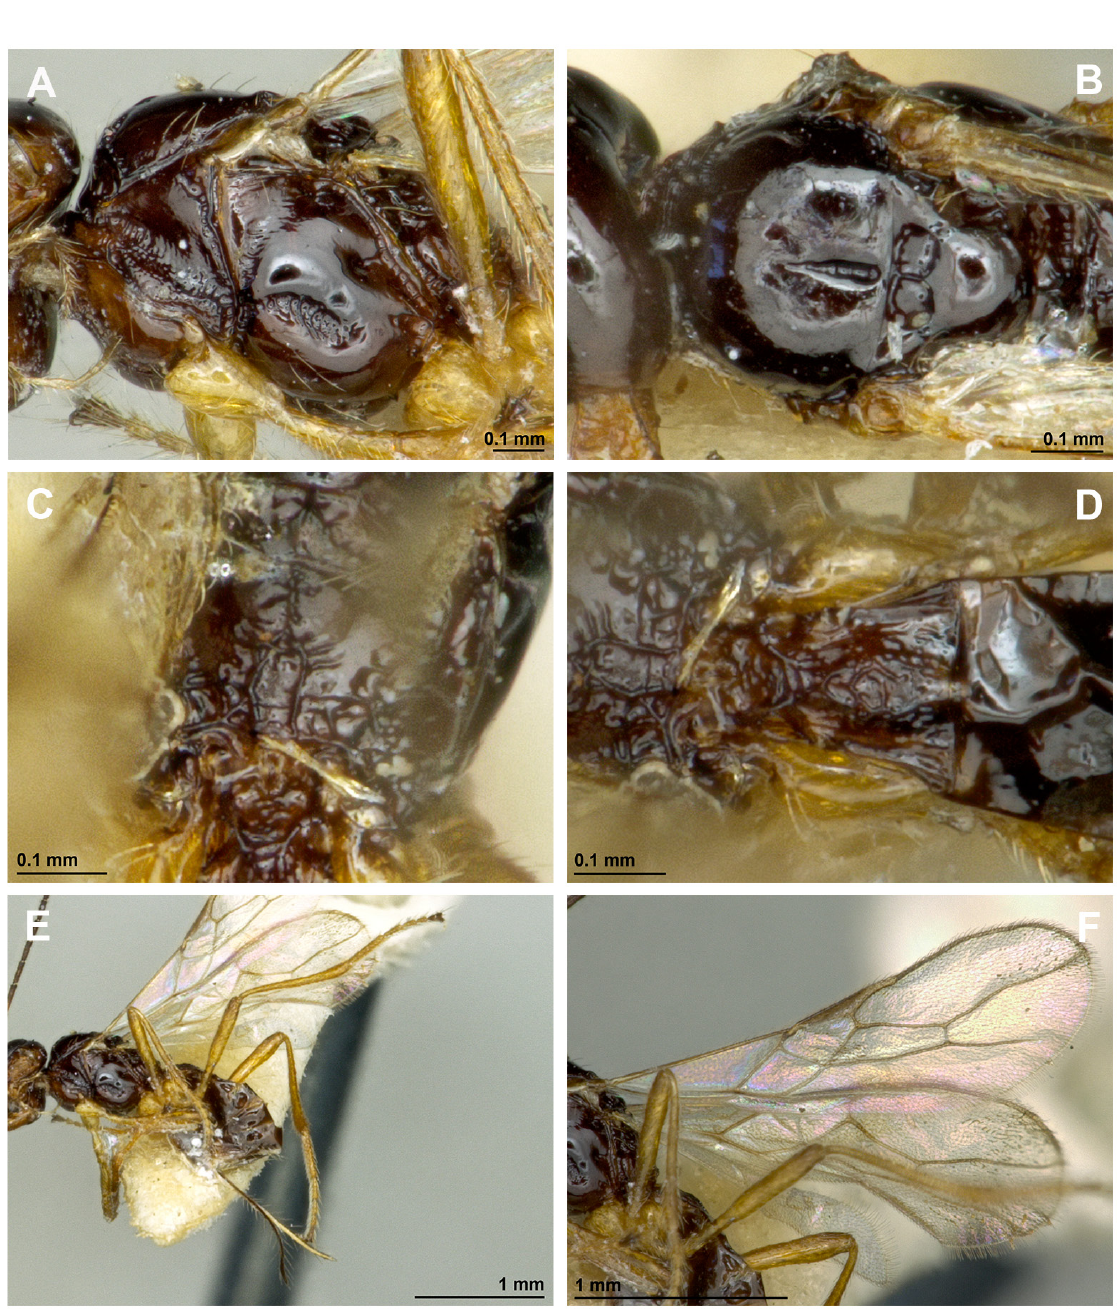
Fig. 44. Asobara natalensis Peris-Felipo, sp. nov., ♀, holotype (BMNH 1927-25). A . Mesosoma, lateral view. B . Mesoscutum, dorsal view. C . Propodeum. D . First metasomal tergite, dorsal view. E . Hind leg, metasoma and ovipositor, lateral view. F . Fore